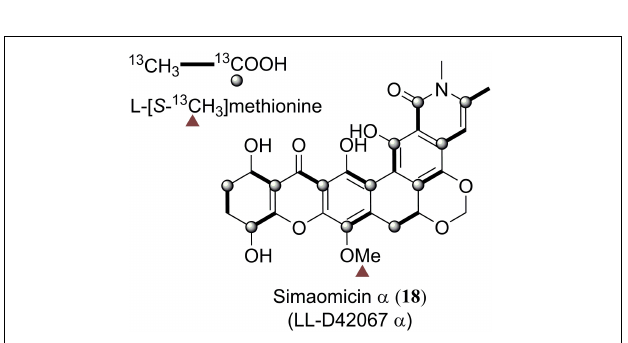
FIGURE 7 | Biosynthetic origins of carbons in simaomicin α ( 18